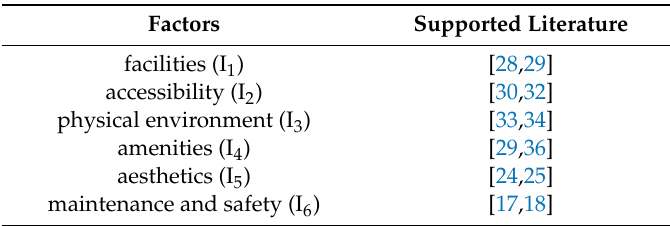
Table 1. Factors influencing the environmental